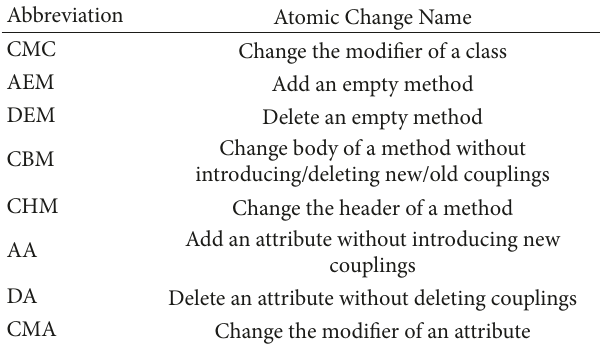
Table 1: Categories of atomic